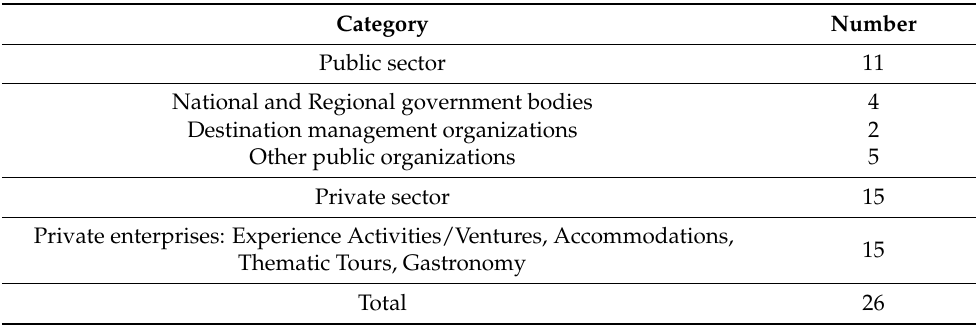
Table 2. Number of interviewed stakeholders per